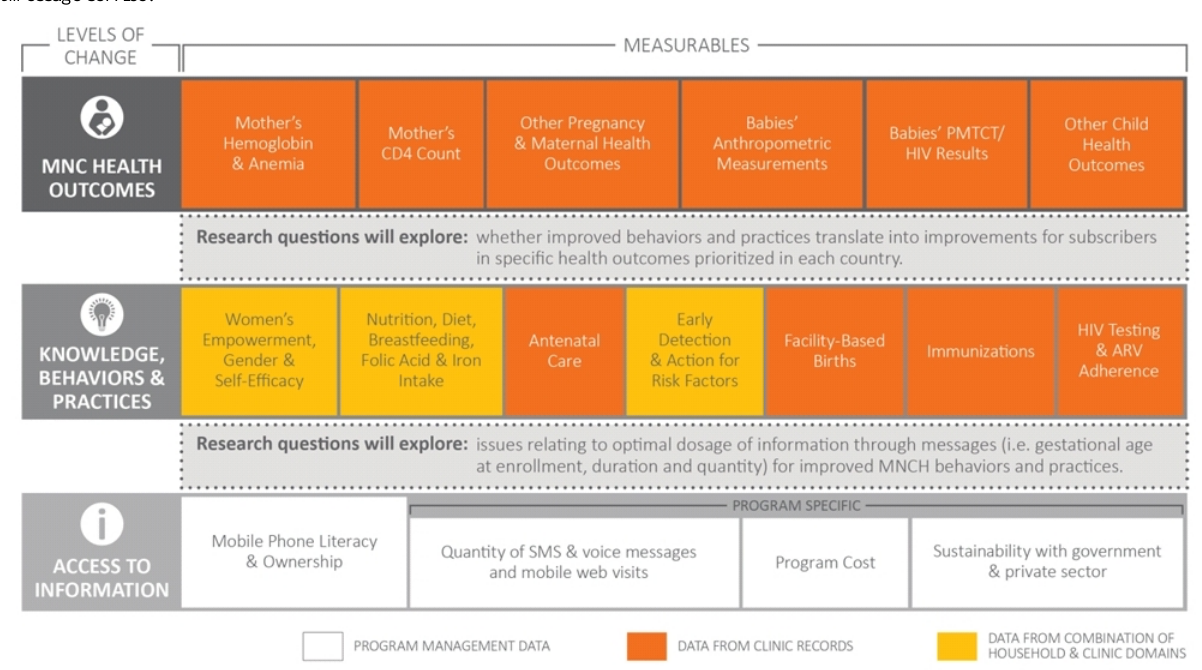
Figure 1. Mobile Alliance for Maternal Action theory of change and priority outcomes. ARV: antiretroviral; HIV: human immunodeficiency virus; MNC: maternal, newborn, and child; MNCH: maternal, newborn, and child health; PMTCT: prevention of mother to child transmission (of HIV); SMS: short message